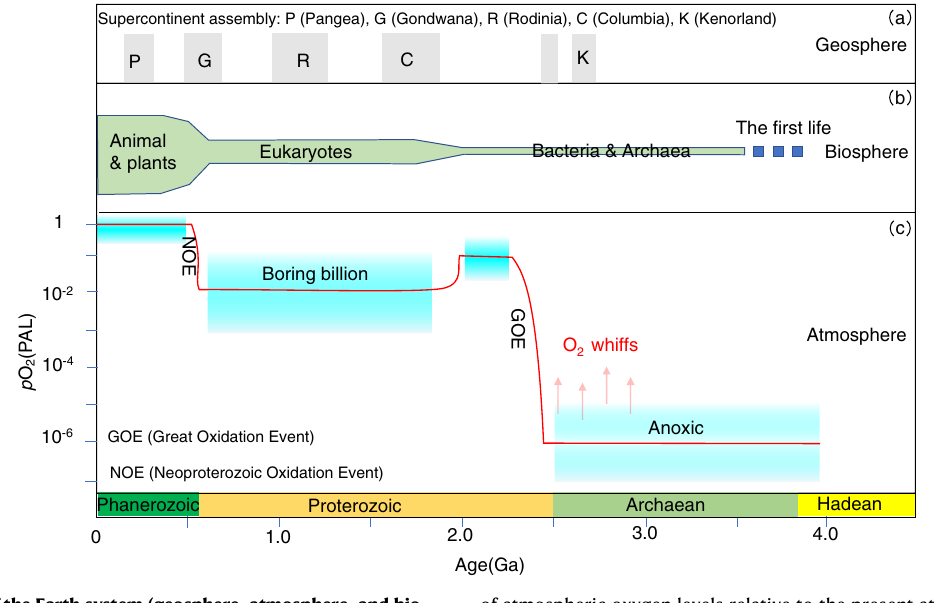
of atmospheric oxygen levels relative to the present atmospheric level 10 ; the blue boxes show a range of atmospheric O 2 level inferred from various geo- logical proxy constraints, and the red solid line shows one plausible evolution path of O 2